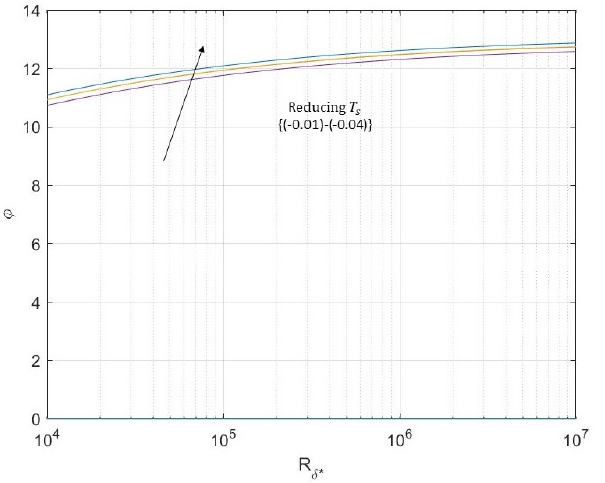
Figure 14. Plot illustrating predictions of asymptotic neutral waveangle φ against R δ ∗ for type I modes for T s = ( − 0.01 ) − ( − 0.04 ) . Smaller T s values move the plots up as shown by the arrow.